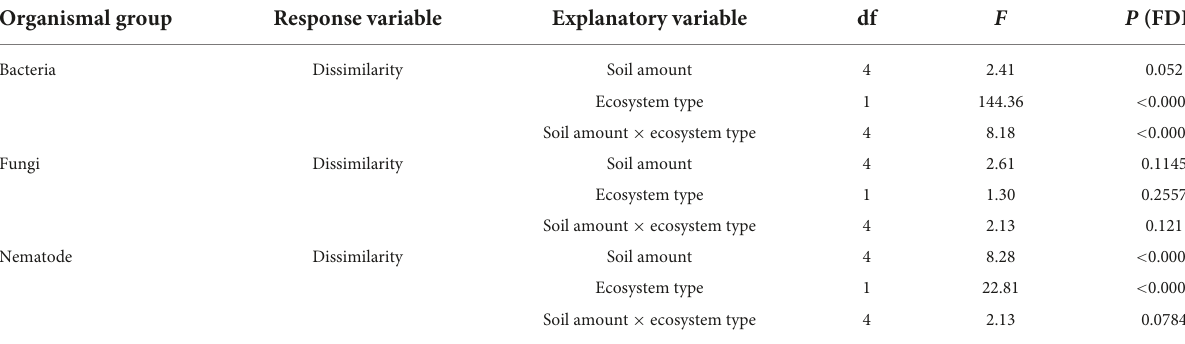
TABLE 2 ANOVA of among-sample heterogeneity in community structure among replicate samples. Organismal